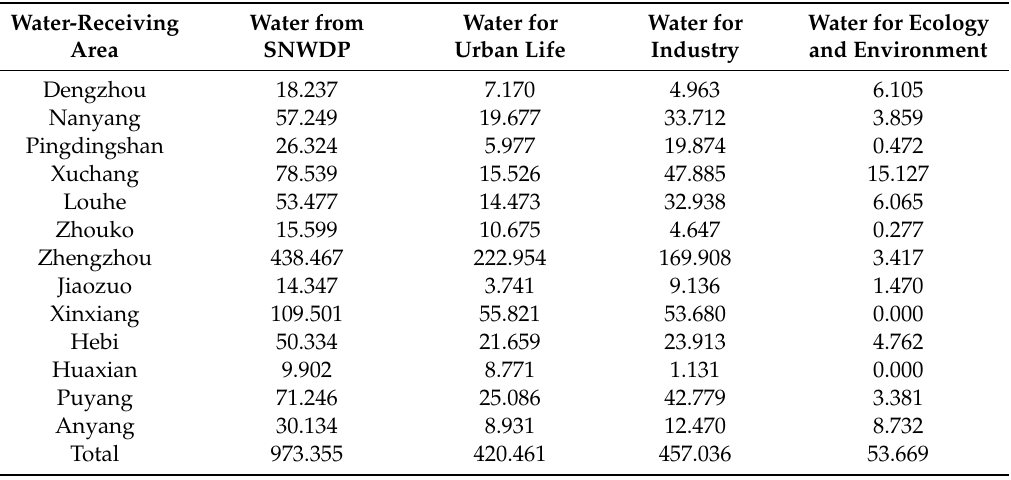
Table 2. Water supply pattern in each water-receiving city under di ff erent departments by 2016 (10 6 m 3 ).